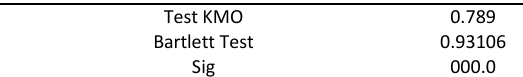
Table 4: KMO and Bartlett test of the questionnaire